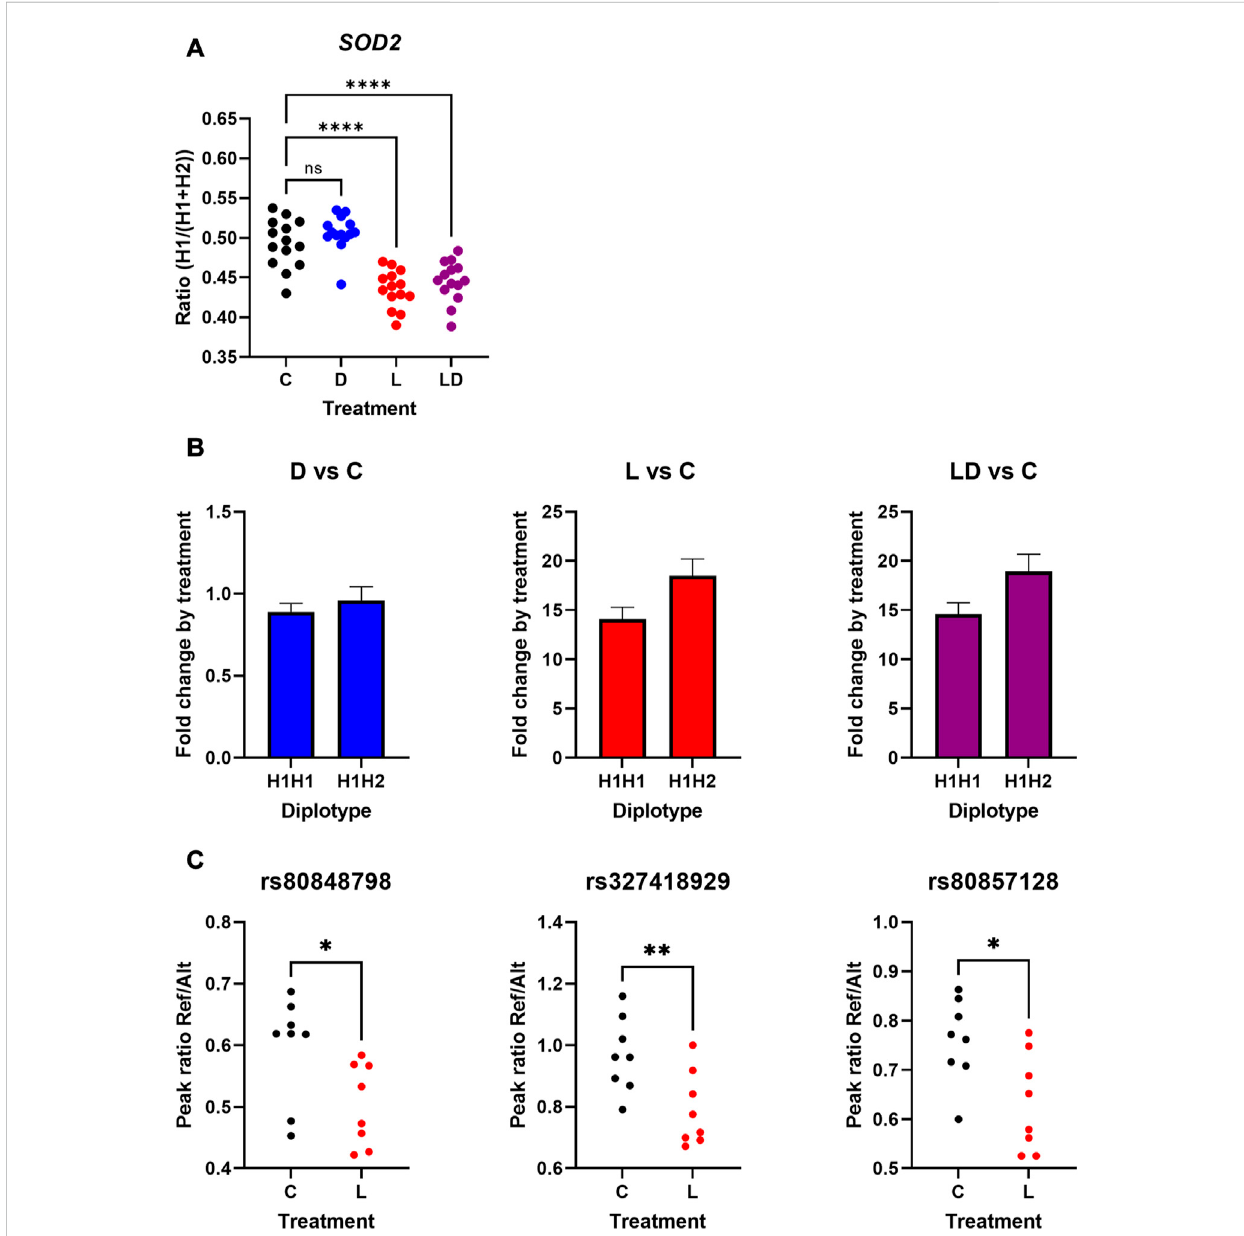
FIGURE 2 LPS-dependent cis -regulatory effects on the expression of the porcine SOD2 in PBMCs. (A) : Haplotype-level allelic ratios of SOD2 depending on treatment ( n =14 heterozygoussamples). (B) :Fold-changeresponse of SOD2 to treatment dependingon haplotype (H1H1 n = 6;H1H2 n =14). (C) :Peak ratiosofthree SOD2 SNPsdepending ontreatment ofadifferentsetofinformativePBMCs( n =8). Pleasenote thatthereference alleles wereassignedto H1, and the alternative alleles to H2, respectively C: vehicle control. D: Dexamethasone treatment (blue). L: LPS treatment (red). LD: LPS